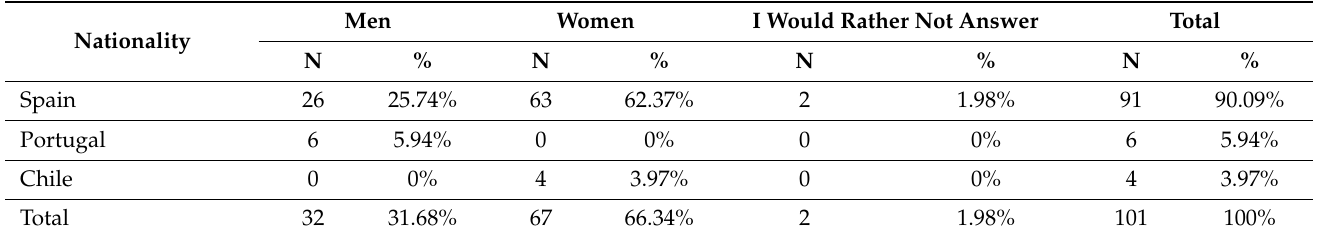
Table 1. Frequency analysis by gender and nationality.